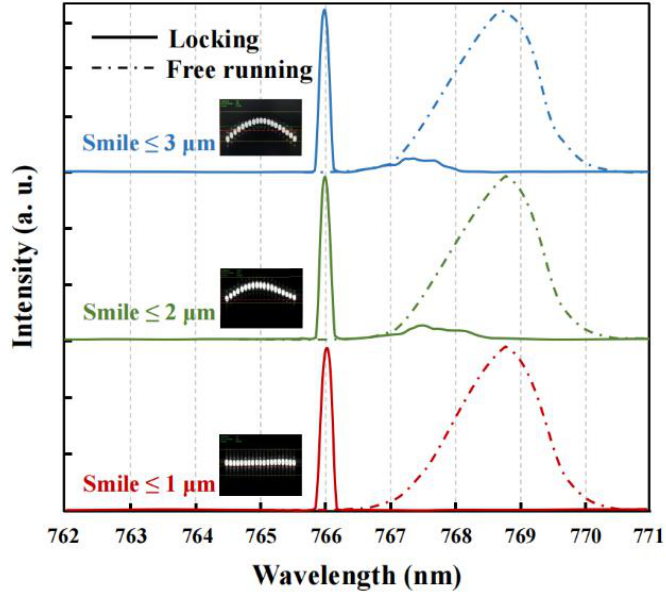
Figure 3. The influence of the smile effect on the linewidth of the external cavity feedback diode laser array. The dashed curves represent the spectral characteristics of the free-running diode laser arrays, while the solid curves represent the spectral characteristics of the external cavity diode laser arrays.